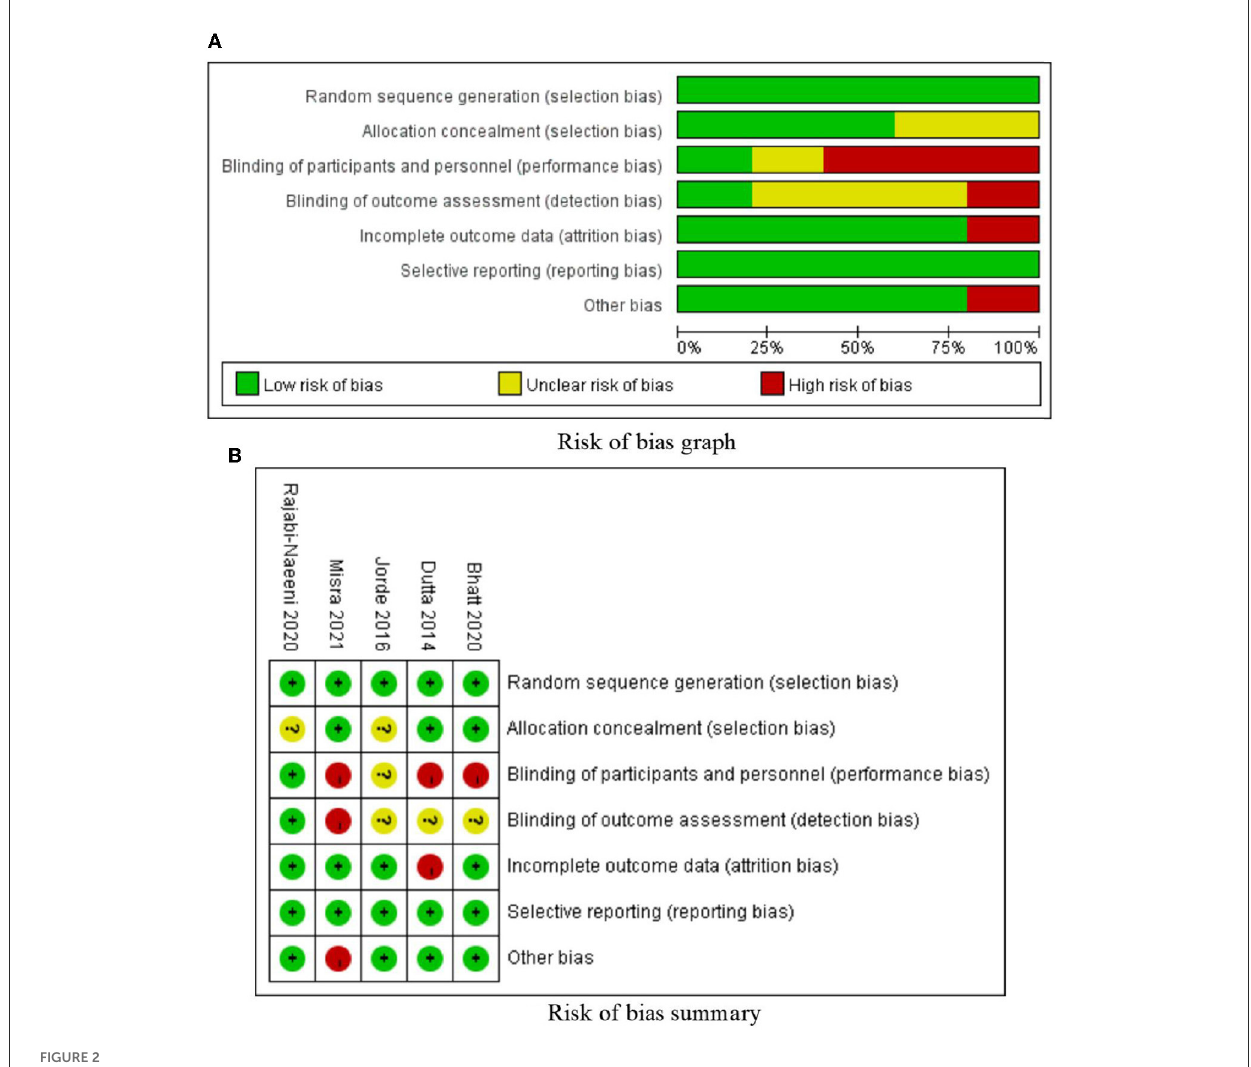
FIGURE2 Risk of bias.